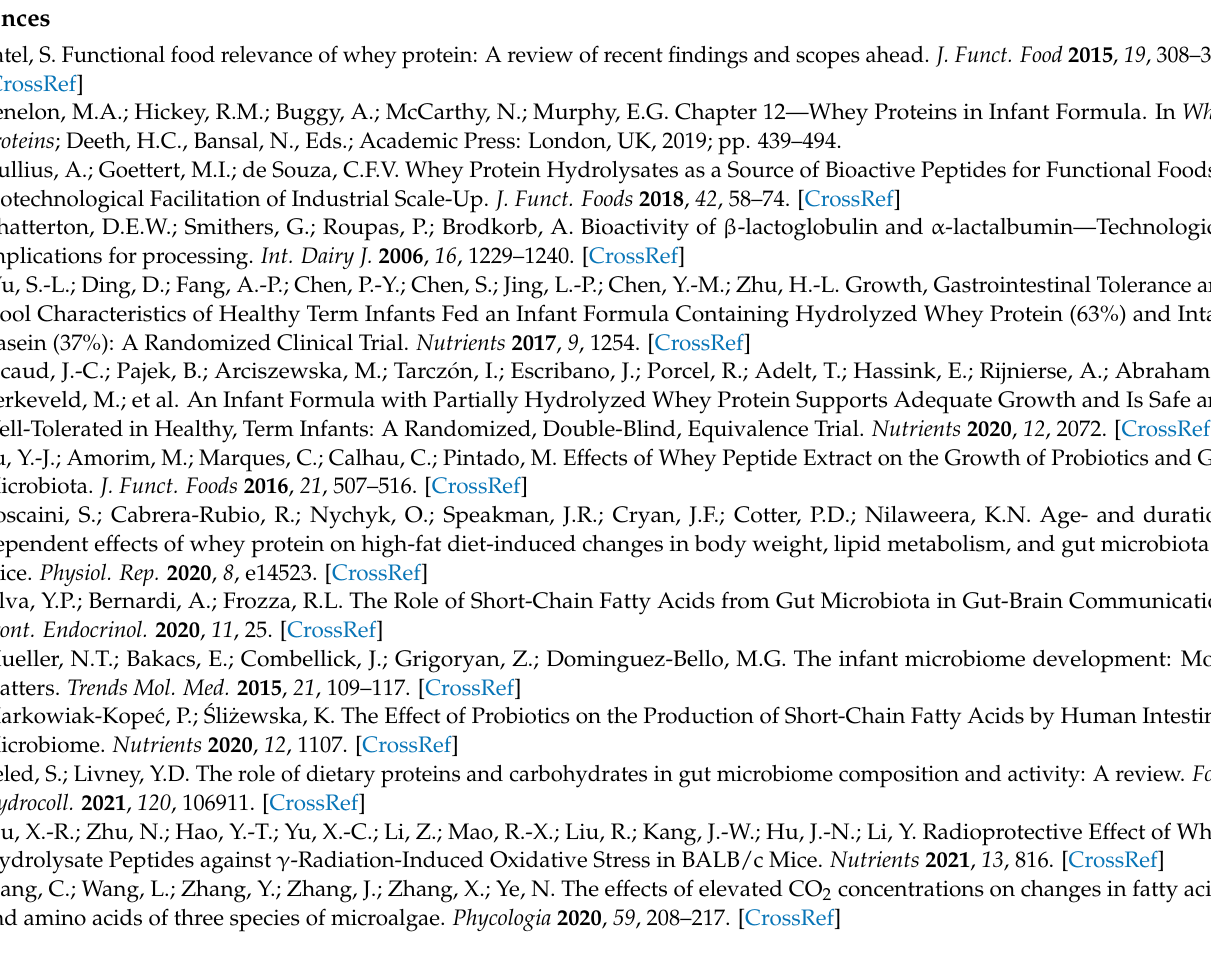
Wiener curves. Figure S3: Rank-abundance curves. Figure S4: Species-accumulation curves. Figure S5: Venn diagram of OTUs. Figure S6: The histogram of LDA effect size